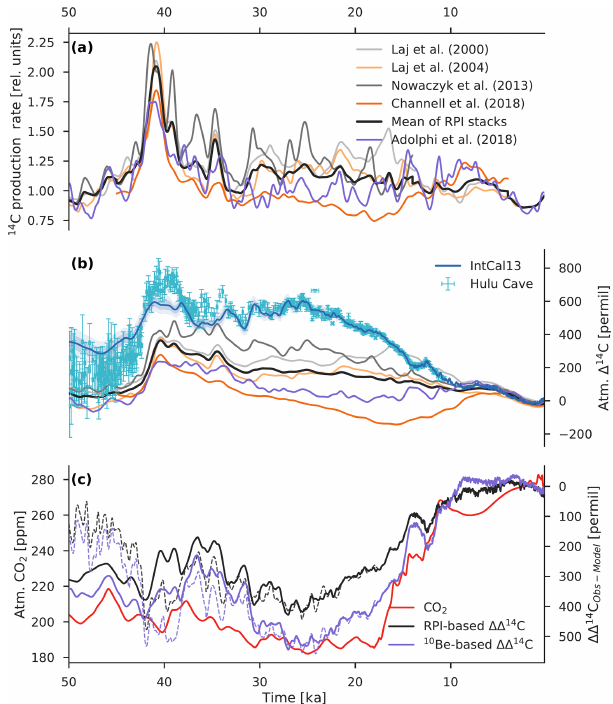
Figure 7. Component of atmospheric (cid:49) 14 C variability caused by production changes alone. (a) Relative 14 C production rate as in- ferred from paleointensity data (gray) and from polar ice-core 10 Be fluxes (purple). The heavy dark gray line is the mean paleointensity- based 14 C production rate. (b) Modeled (cid:49) 14 C records based only on 14 C production changes compared with the reconstructed Int- Cal13 and Hulu Cave (cid:49) 14 C records. The modeled records are given by scenario MOD that assumes a constant preindustrial car- bon cycle. (c) Difference between reconstructed (cid:49) 14 C and model- simulated (cid:49) 14 C using averaged paleointensity data (RPI-based (cid:49)(cid:49) 14 C; gray) and the ice-core 10 Be data of Adolphi et al. (2018) ( 10 Be-based (cid:49)(cid:49) 14 C; purple) compared with the atmospheric CO 2 record (red). Solid lines show the IntCal13–model difference, whereas dashed lines show the Hulu–model difference. The (cid:49)(cid:49) 14 C curve indicates changes in (cid:49) 14 C that can be attributed to some com- bination of carbon cycle changes, uncertainties in the reconstruction of the 14 C production rate, and uncertainties in the IntCal13 and Hulu Cave (cid:49) 14 C